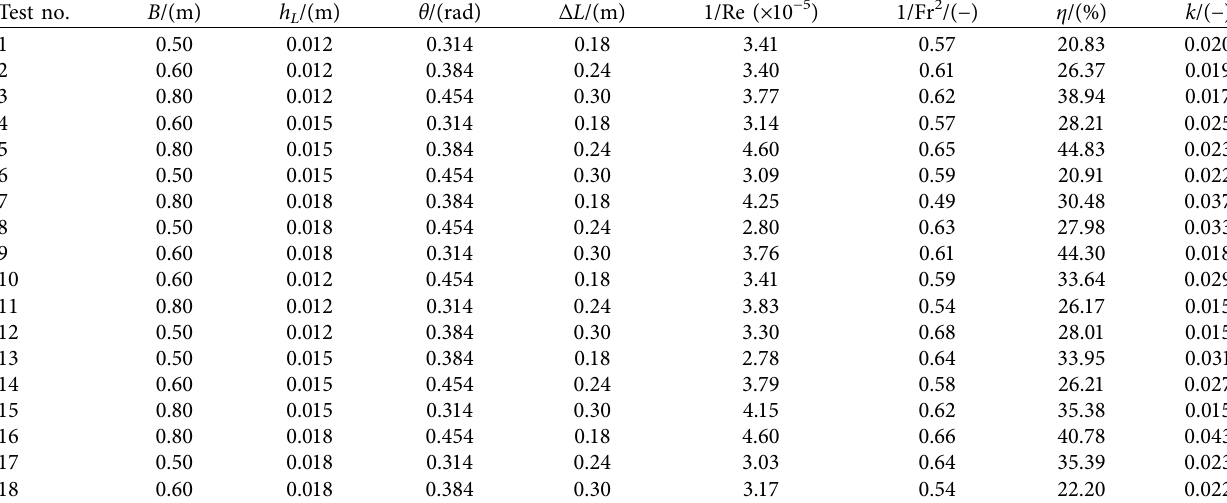
Table 4: Orthogonal test results.